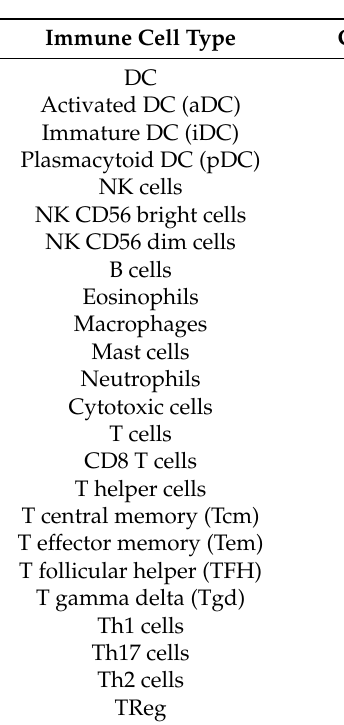
stromal, and immune scores based on the ESTIMATE algorithm. ( D ) The lollipop plot shows the correlation of SPOCD1 expression with immune cell infiltration conducted by ssGSEA. ( E ) Enrichment score of macrophages according to the difference SPOCD1 expressions. ( F – K ) The correlation of SPOCD1 expression with immune cell infiltration in CRC acquired from the TIMER online tool. (*** p < 0.001). Table 5. Correlation between the infiltration level of several types of immune cells and the expression of SPOCD1 in